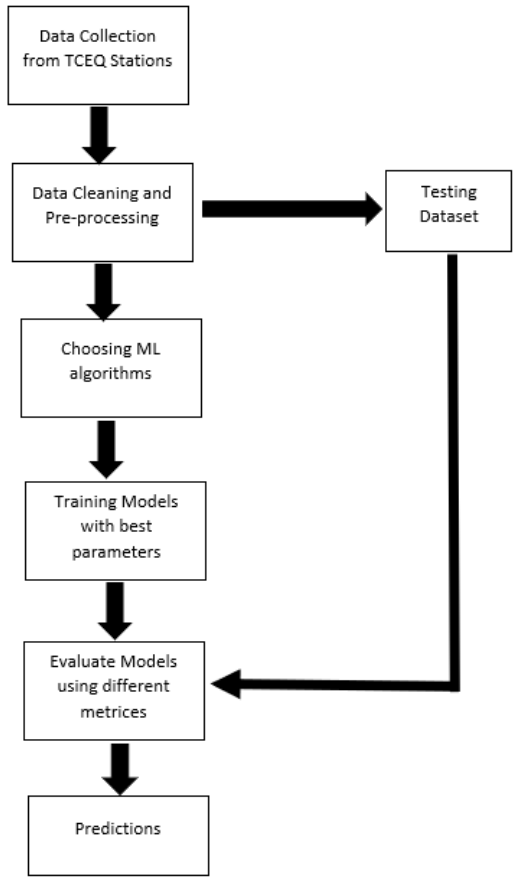
Figure 1. Flowchart of the